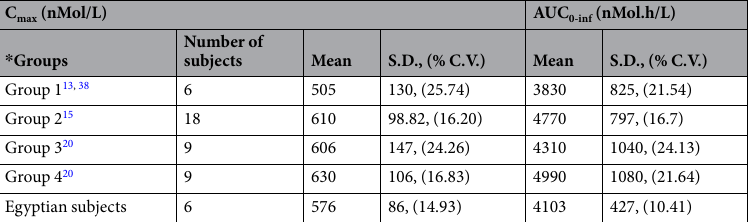
Table 2. One way ANOVA results at P < 0.05 for C max and AUC 0-inf after administration of 25 mg empagliflozin in German and Egyptian subjects. * Studied groups from pharmacokinetic studies conducted in white German subjects using 25 mg EG 13, 15, 20, 38 showed no significant difference at P > 0.05, with P = 0.283 for Cmax and P = 0.064 for AUC 0-inf . Abbreviations: AUC = area under the curve; % C.V. = percent coefficient of variation; S.D. = standard deviation.